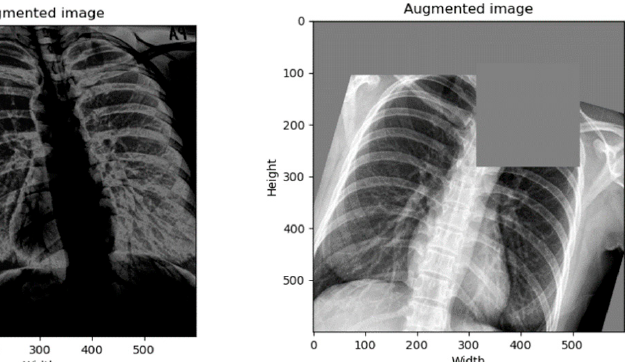
Figure 3. Cropped CXR images of the SCH data set: ( a ) original image; ( b ) histogram of original image; ( c ) bottom-cropped image; ( d ) histogram of bottom-cropped image.